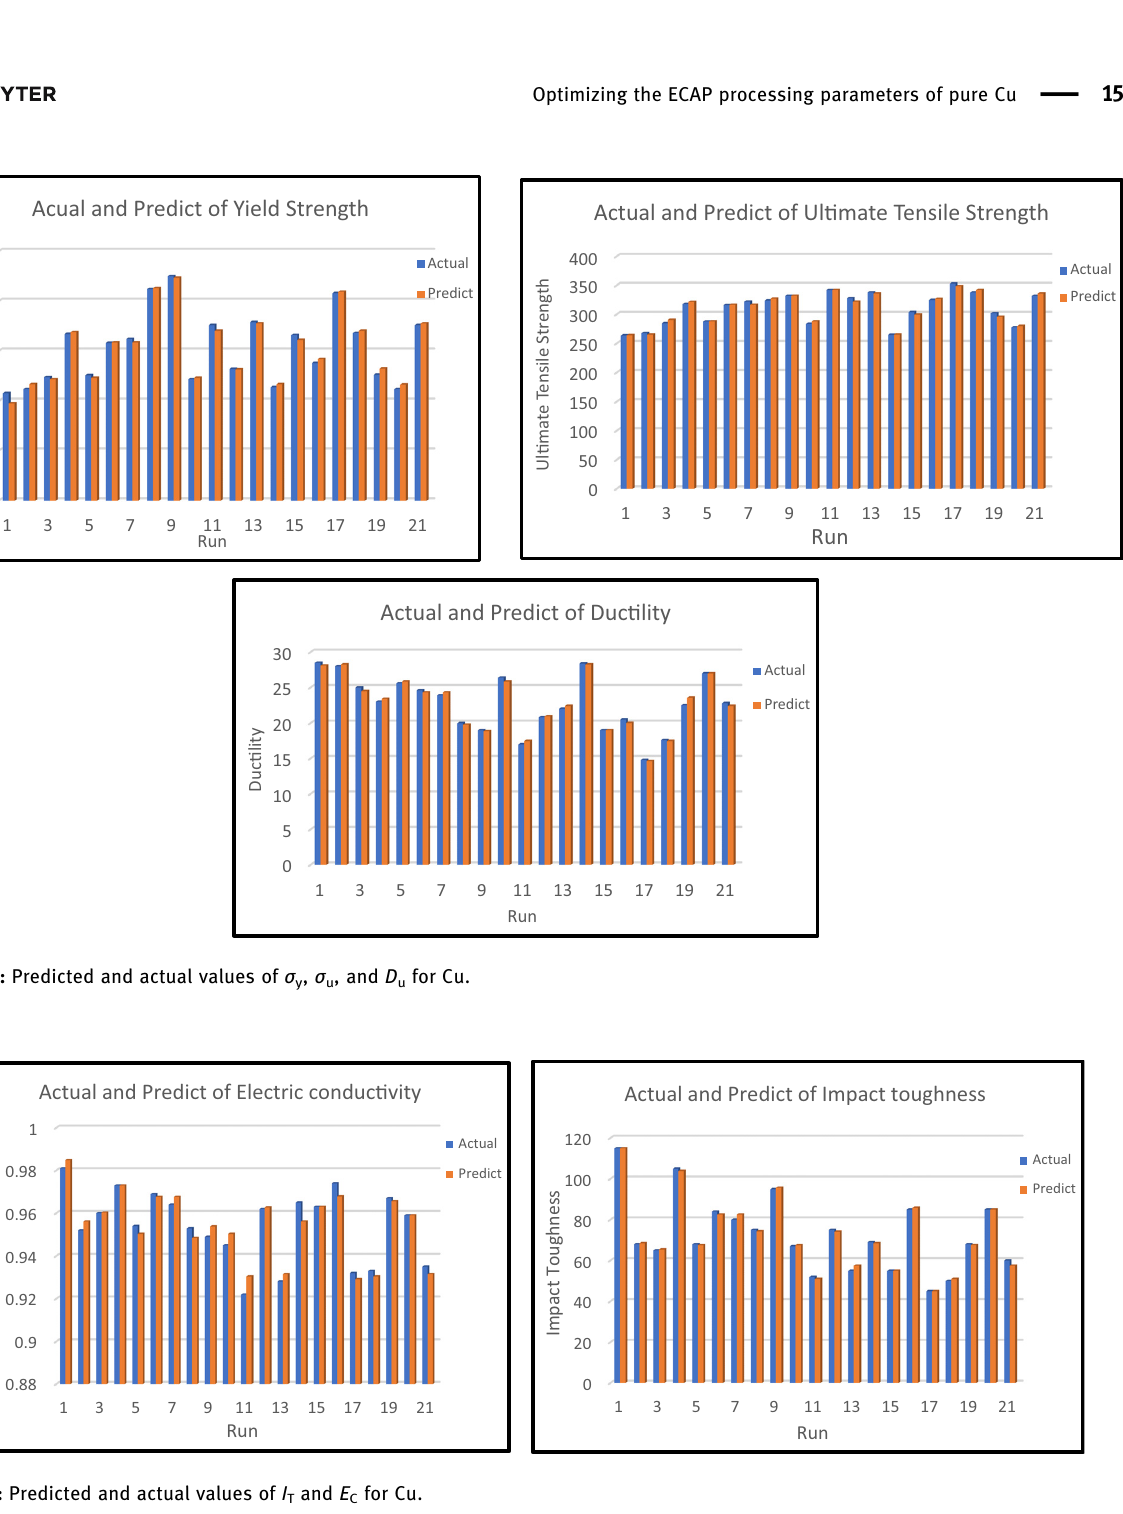
Figure 11: Predicted and actual values of I T and E C for Cu.